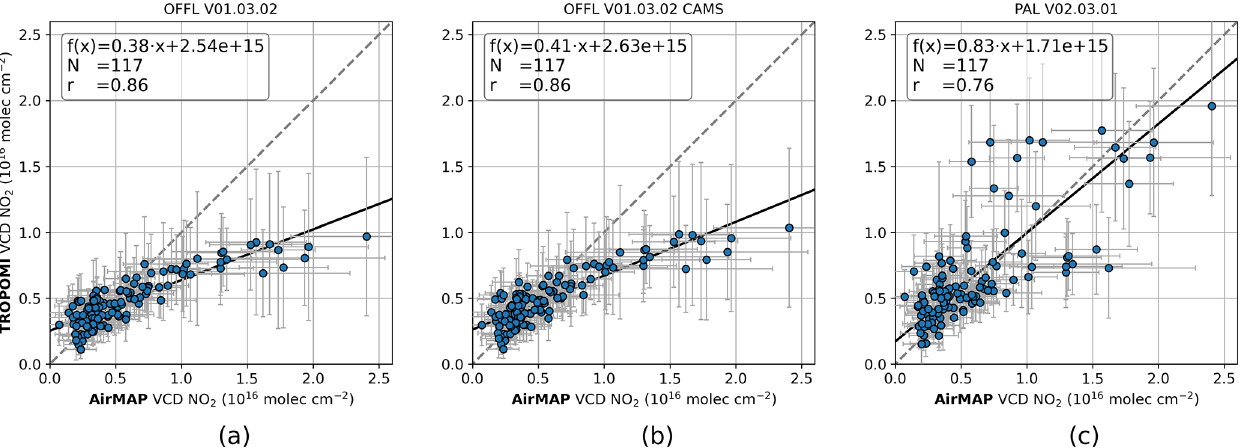
Figure 9. Scatter plots of TROPOMI NO 2 VCDs vs. co-located AirMAP NO 2 VCDs for different versions of TROPOMI data: (a) operational OFFL V01.03.02, (b) V01.03.02 based on the CAMS NO 2 profiles, and (c) PAL V02.03.01. AirMAP measurements are considered as co- located and gridded to the TROPOMI pixel if they are taken ± 30min around the S5P overpass and are covering at least 75% of the TROPOMI pixel. The horizontal error bars represent the 10th and 90th percentiles of airborne measurements within the TROPOMI pixel. Vertical error bars show the reported precision of the TROPOMI tropospheric NO 2 VCD. Error bars on the TROPOMI measurements are shown to illustrate their magnitude and are not shown for all further plots for better visibility of the